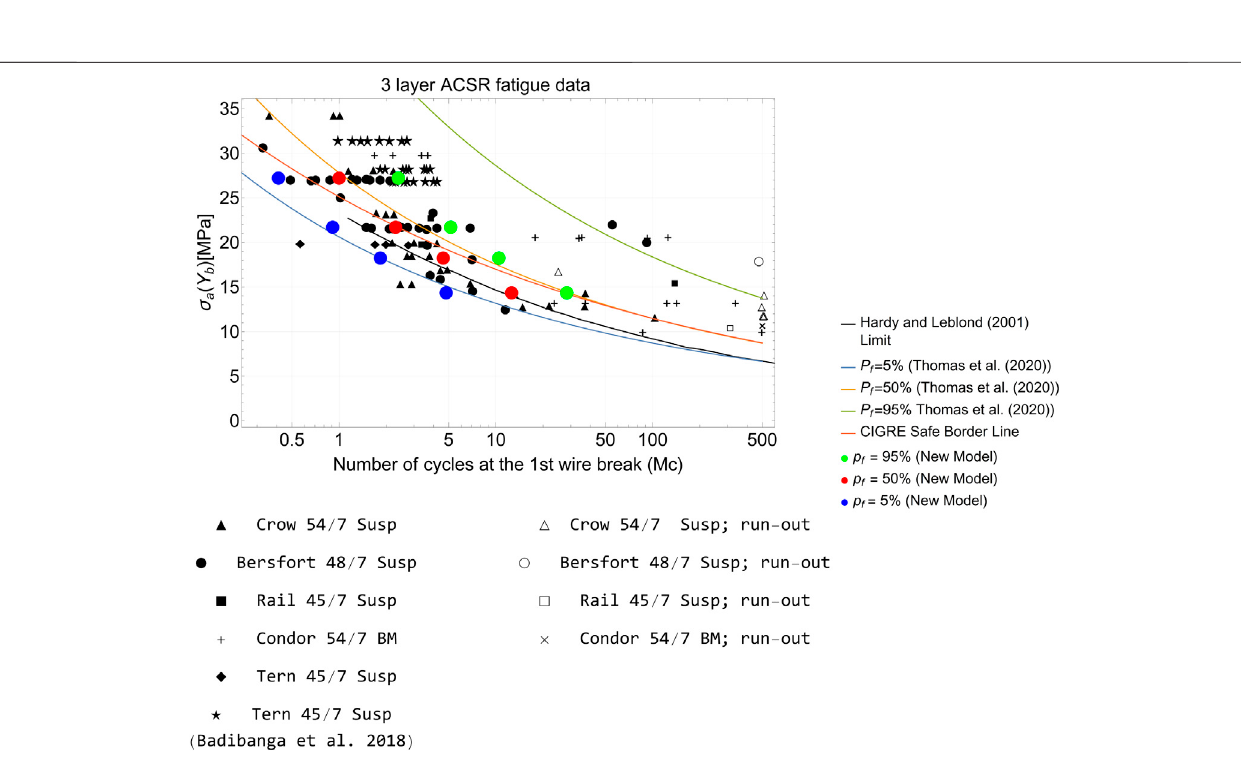
Frontiers in Built Environment |